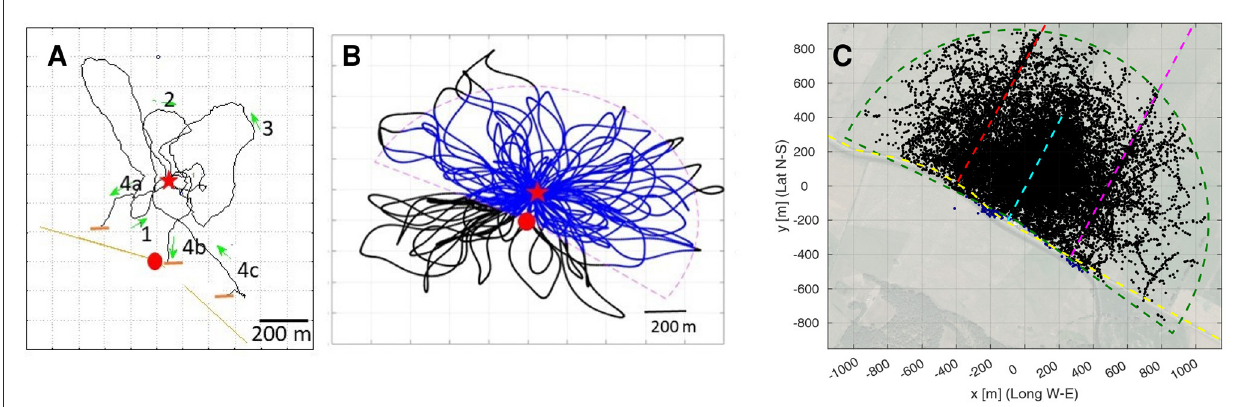
FIGURE3 The structure of search flights. (A) Example of a bee’s search flight (Bee 05 from Home Area E). (B) Example of a simulated bee’s flight. Two models were run, Model S with search loops in all directions (black and blue trajectories) and Model R in which fixes outside the radar range (dashed line) were excluded (only blue parts of the trajectories). (C) All fixes of all search flights plotted together with the radar range(green dashed line) with the release site at the origin. Fixes in the range in black, in blue the approx. 0 . 45% outside that range (in proximity of the radar, south of the radar range). The dashed line (red, cyan, magenta and yellow) highlight the edges (elongated ground structures) of the test site. Red dot: radar site, Red star: release site, Green arrows: direction of